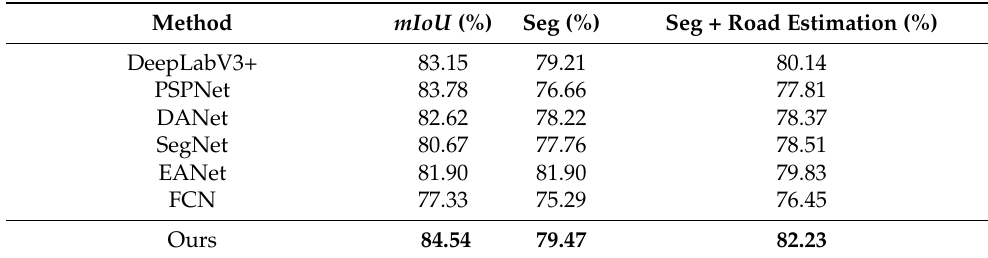
Table 2. Comparison of model performance on the FreiburgForest dataset. The best performers are highlighted in